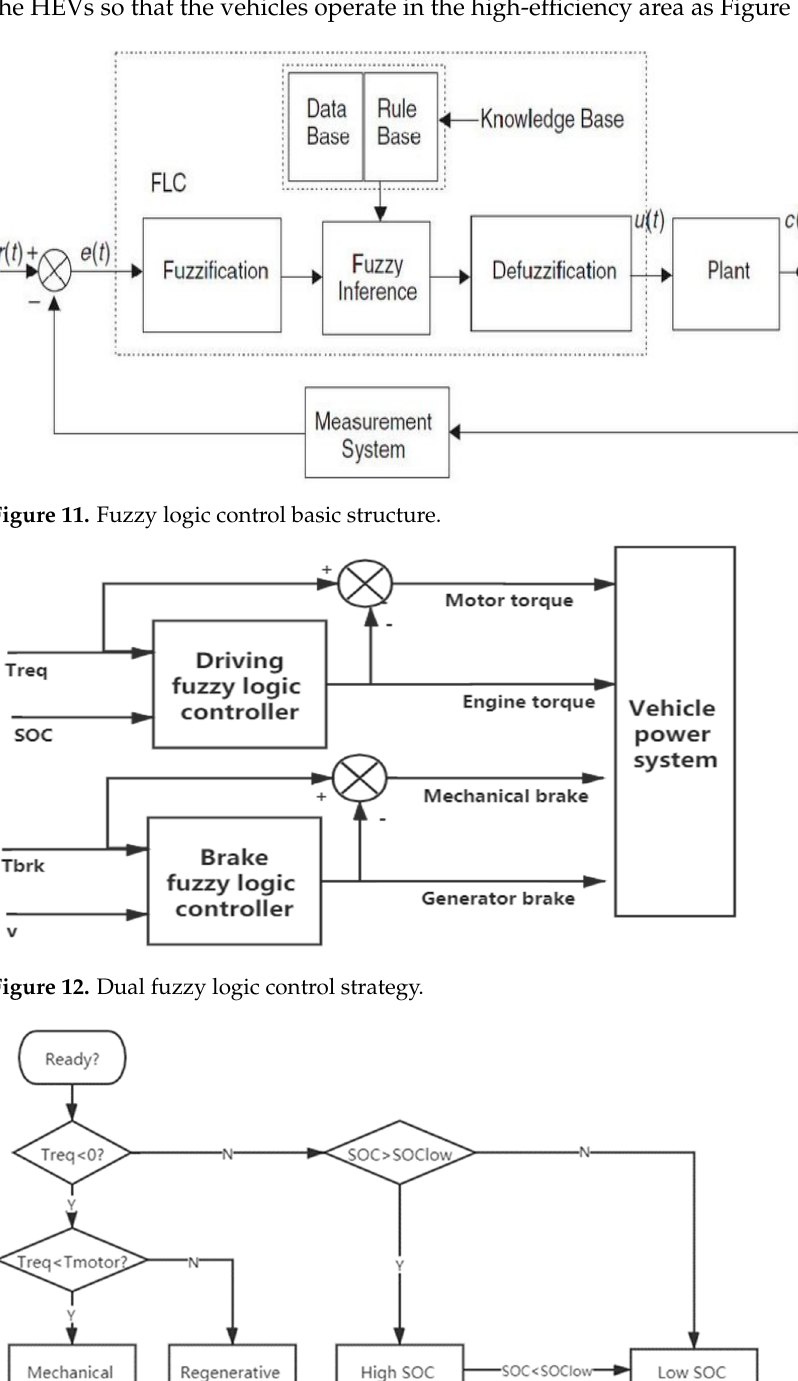
Figure 12. Dual fuzzy logic control strategy.